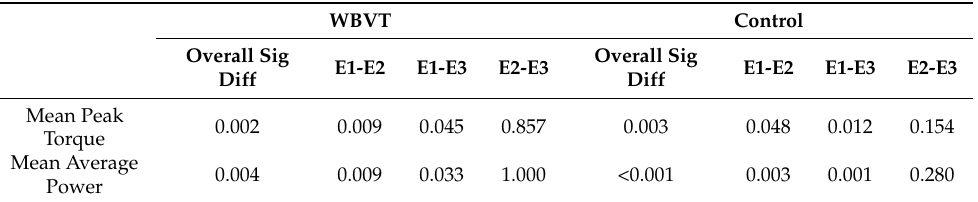
Table 3. Intra-group comparison and post hoc analysis of primary outcome